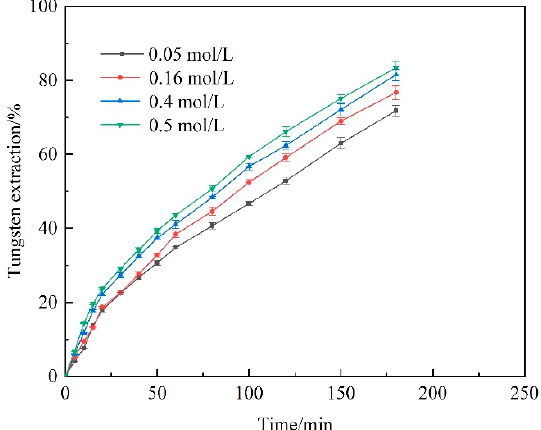
Figure 9. Effect of fluoride ion concentration on the leaching efficiency of tungsten.